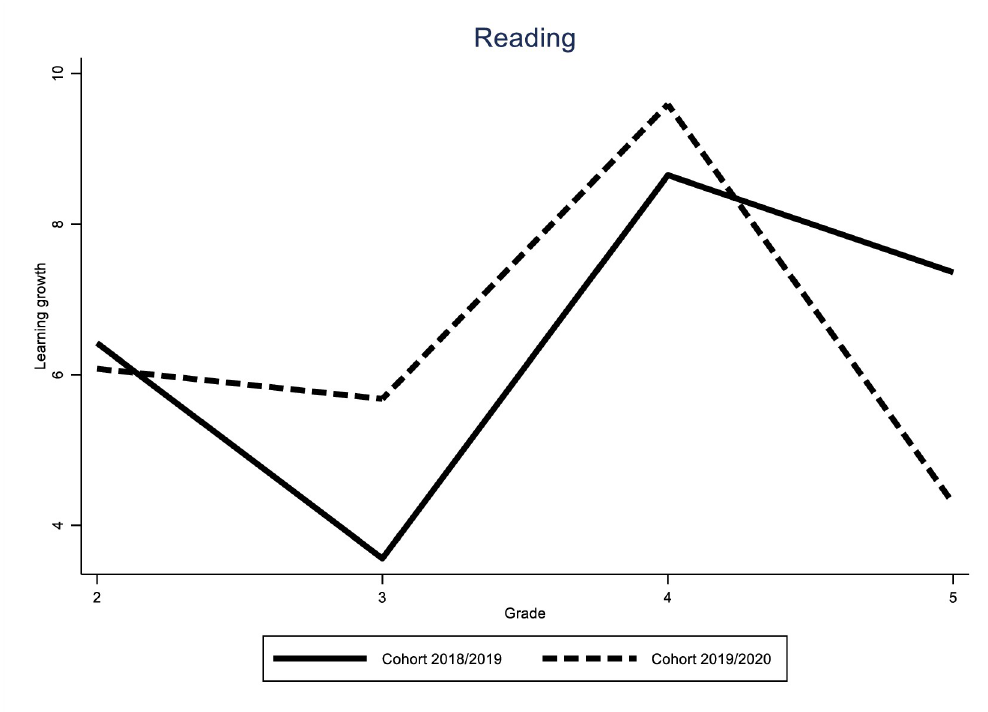
Fig 8. Learning gain: Grade 5 students of 2018/2019 compared to Grade 5 students of 2019/2020 –reading.